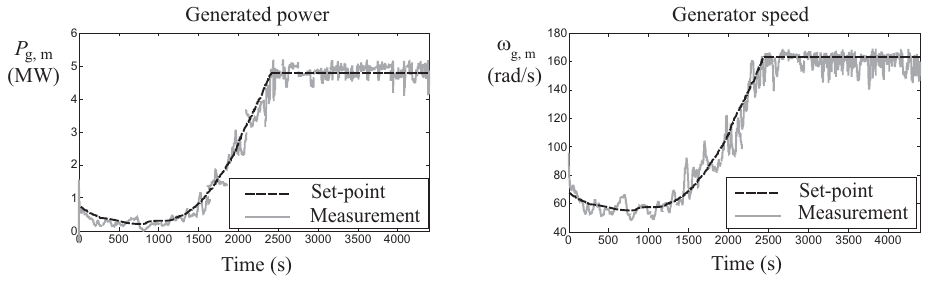
Figure 9. Reference and measured P g , m and ω g , m outputs.